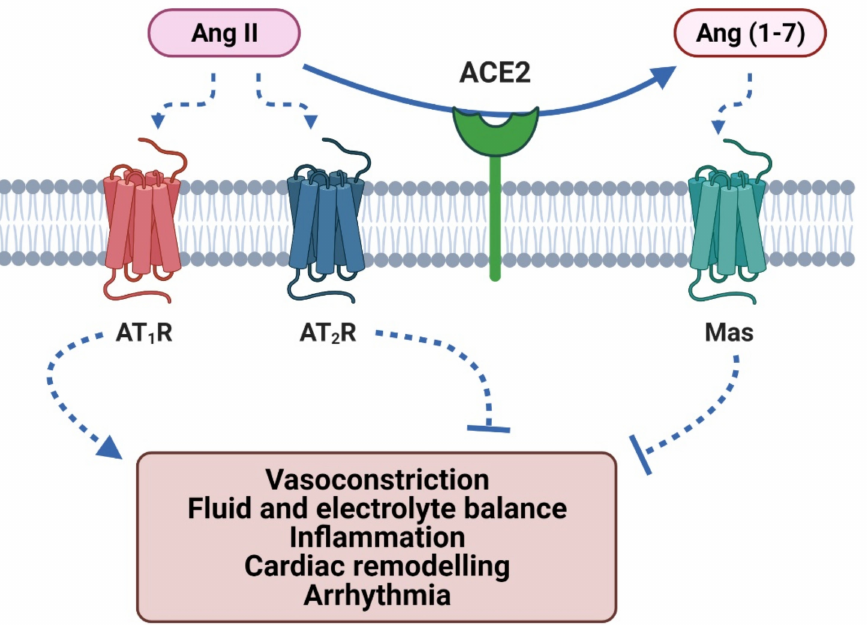
Figure 1. Effects of Ang II and its metabolite Ang (1-7). Ang II facilitates the “vasoconstrictive arm” of the RAAS via activation of angiotensin II type 1 receptors (AT 1 R). The “vasorelaxant arm” counteracts these effects via angiotensin II type 2 receptors (AT 2 Rs) and Mas receptors. Headed arrows show activation; flat-headed lines represent inhibition (created with